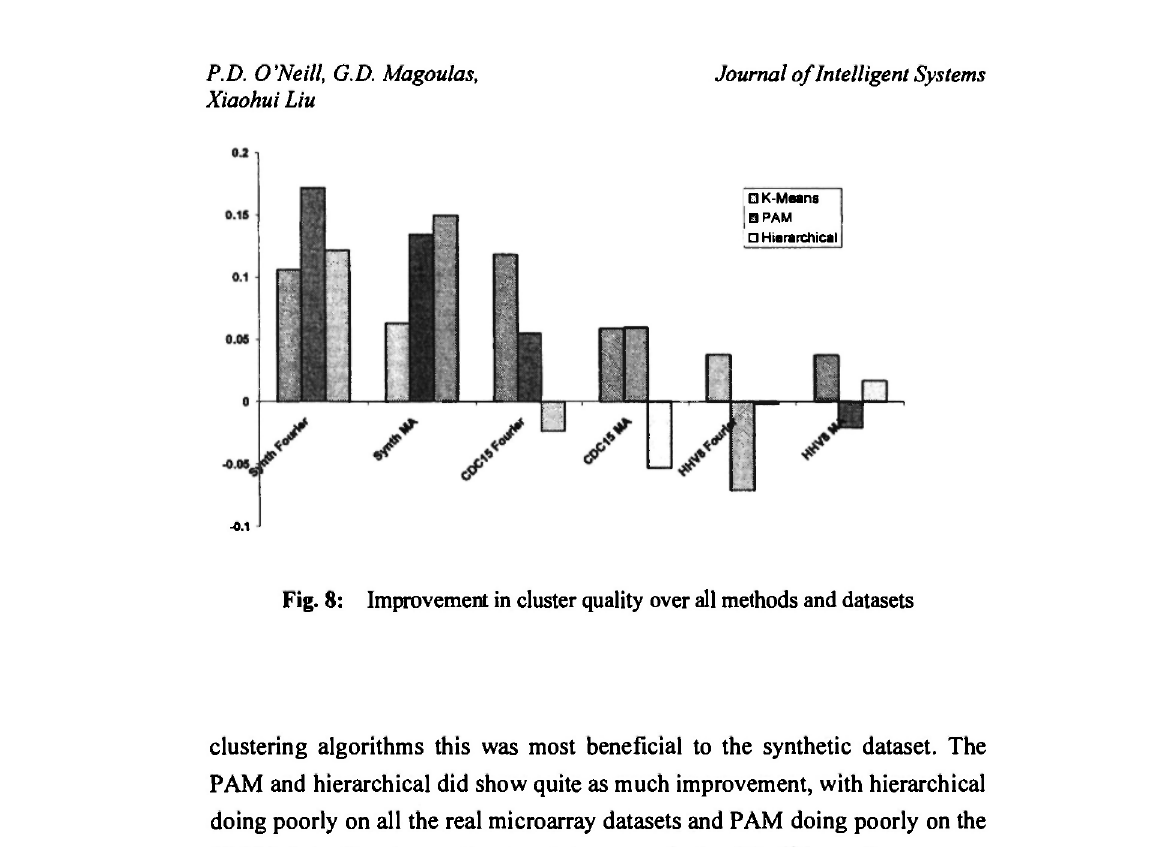
Fig. 8: Improvement in cluster quality over all methods and